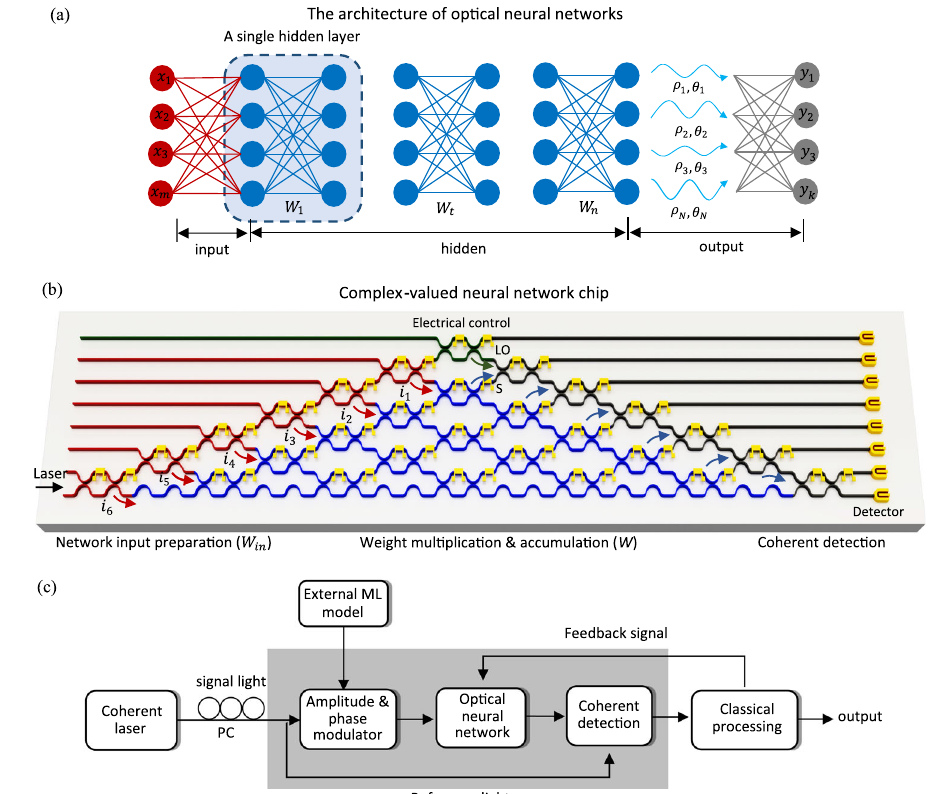
Fig. 1 The composition of complex-valued coherent optical neural network. a An optical neural network is composed of an input layer, multiple hidden layers and an output layer. In our complex-valued design, the light signals are encoded and manipulated by both magnitude and phase during the initial input preparation and network evolution. b The schematic of the ONC in implementing complex-valued networks. The input preparation, weight multiplication and coherent detection are all integrated onto a single chip. The division and modulation of the light signals ( i 1 – i 6 ) are realized by the MZIs marked in red. The green marked MZI separates the reference light that will later be used for coherent detection. The MZIs used to implement the 6 × 6 complex-valued weight matrix are marked in blue. The remaining grey marked MZIs are used for on-chip coherent detection. c The work fl ow of the ONC system. A coherent laser at 1550 nm is used to generate signal light and reference light. The signal light on each path is modulated by its magnitude and phase according to the machine learning (ML) task. The weighted sum operation is accomplished passively through light inference. The measurement results are sent to the electrical interface for processing, including the application of activation function and the calculation of cost function. The ONC chip are then recon fi gured accordingly by the updated weight